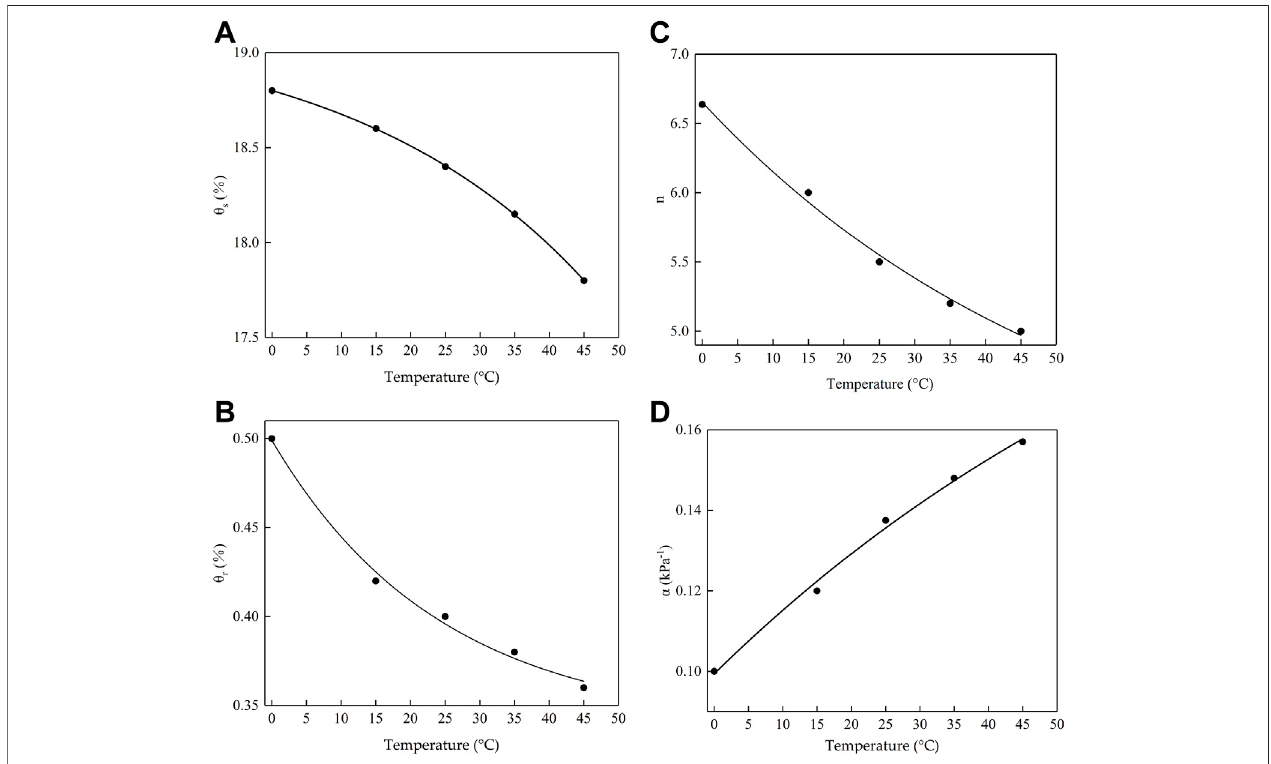
FIGURE 8 | Relationship between the fi tting parameters of the VG model and temperature. (A) θ s and temperature; (B) θ r and temperature; (C) n and temperature; (D) α and temperature.